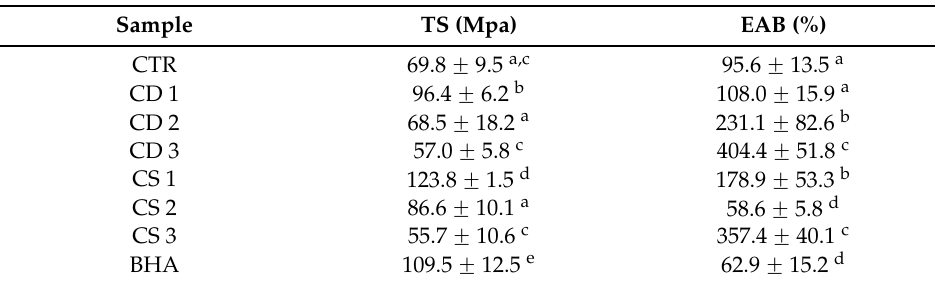
Table 1. The effects of CD and Tara at different concentrations on the tensile strength (TS) and elongation at break (EAB) of gelatine films.